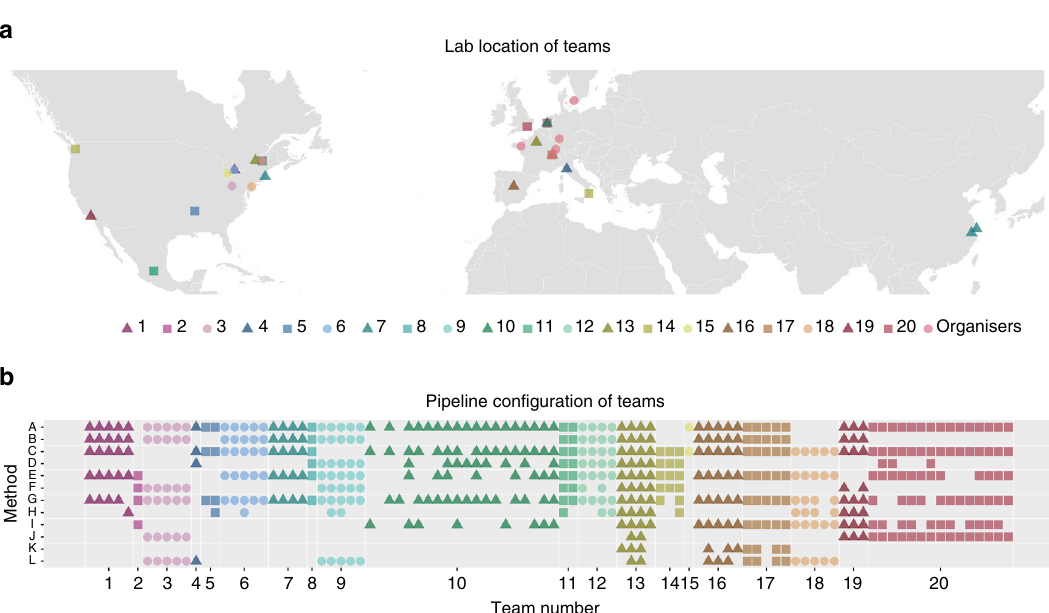
Fig. 2 Summary of teams and tractography pipeline setups. a Location of the teams ’ af fi liated labs. b Con fi guration of the different pipelines used for processing (A: motion correction, B: rotation of b-vectors, C: distortion correction, D: spike correction, E: denoising, F: upsampling, G: diffusion model beyond diffusion tensor imaging (DTI), H: tractography beyond deterministic, I: anatomical priors, J: streamline fi ltering, K: advanced streamline fi ltering, L: streamline